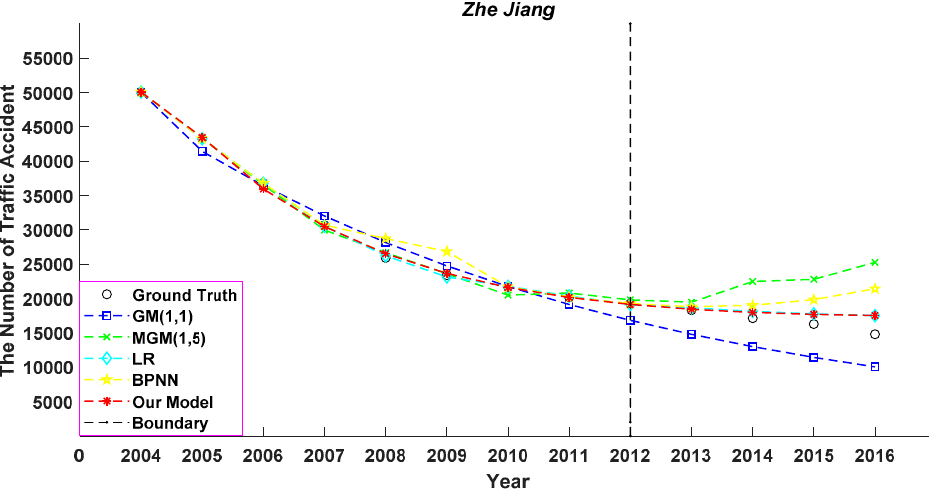
Figure 3. Result of trend prediction for Zhe Jiang province.